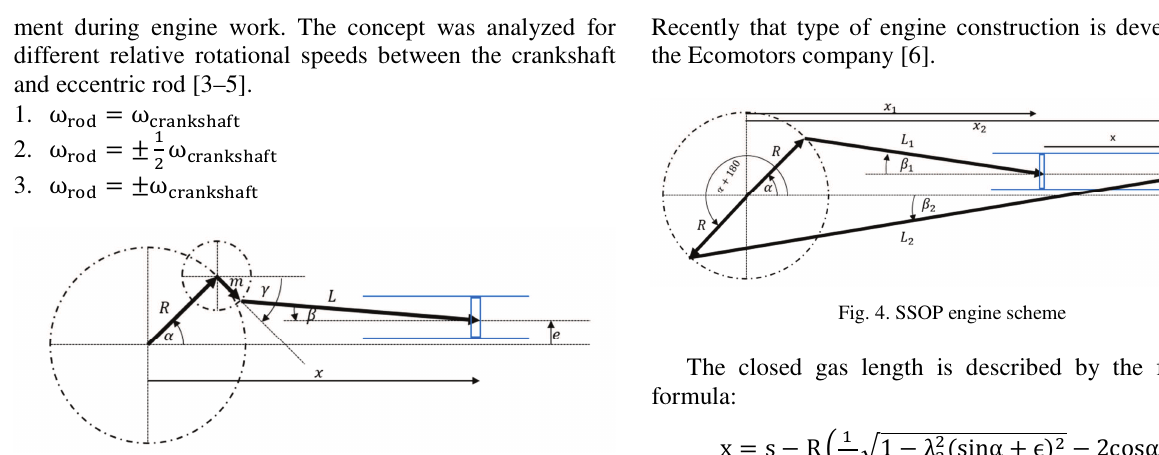
Fig. 2. EE engine scheme